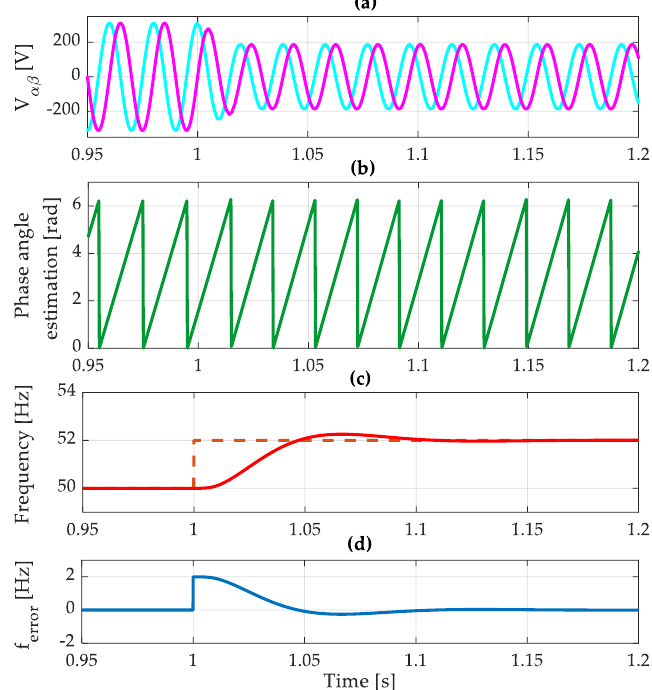
Figure 12. MDSC_n-PLL performance for scenario 1: αβ voltages ( a ), phase angle ( b ), frequency ( c ), and frequency error ( d ).